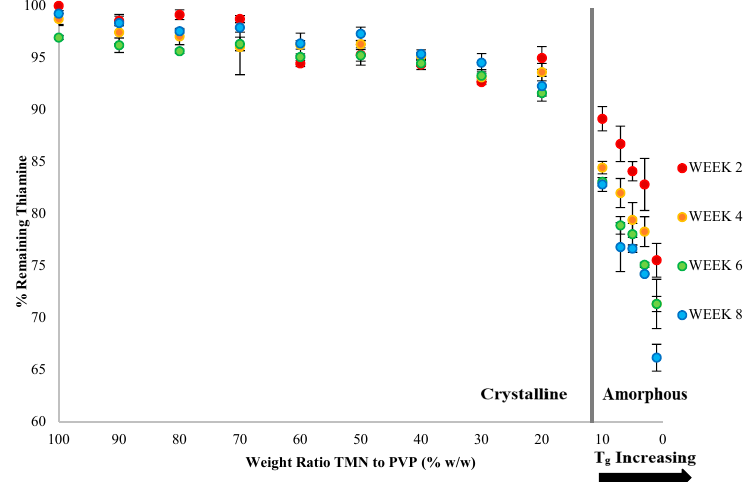
Figure 7. Chemical stability of thiamine in various ratios of TMN to PVP solid dispersions stored at 11% RH and 60 °C for 56 days.